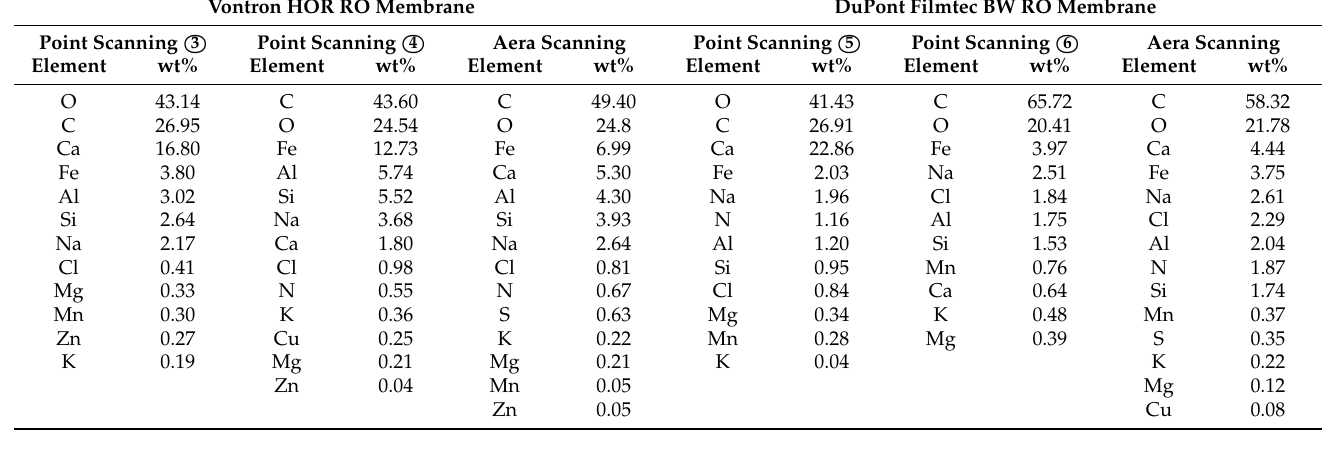
Figure 5. SEM images of fouled Vontron HOR (( a ), 1000 × ; ( c ), 50,000 × ) and DuPont Filmtec BW (( b ), 1000 × ; ( d ), 50000 × ) RO membrane after 3 batch fi ltrations.